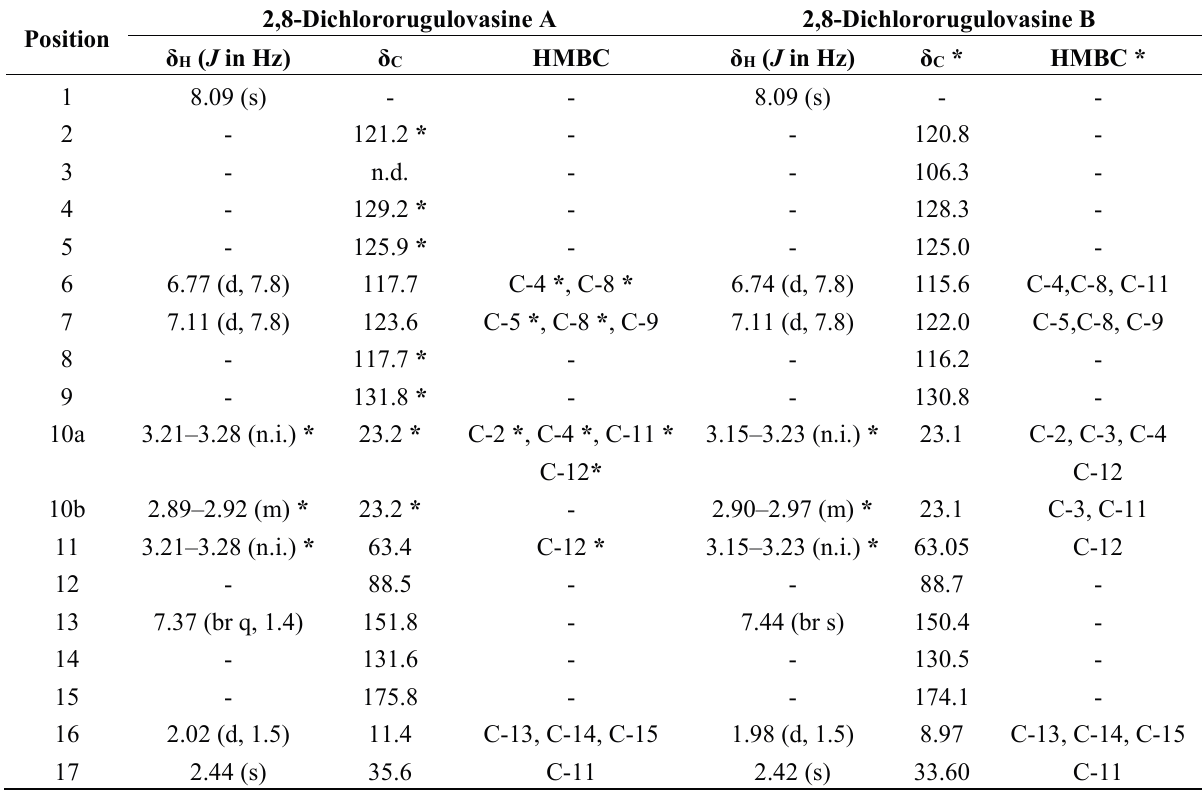
Table 1. 1 H-NMR and HMBC data (600 MHz, methanol- d 4 ) of 2,8-dichlororugulovasine A and